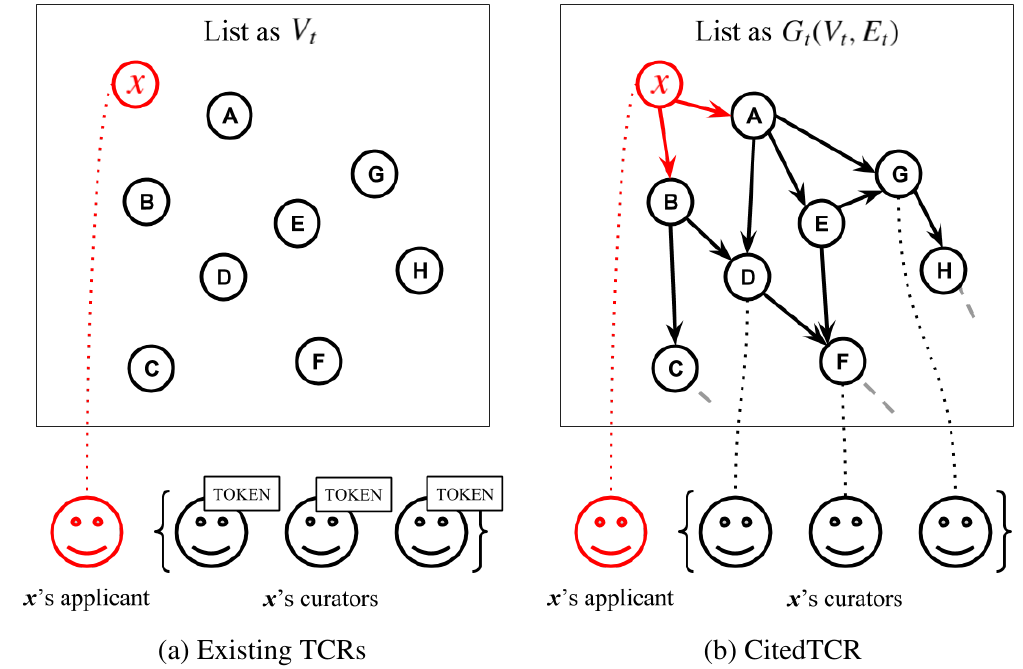
Fig. 1. TCRs in both cases select curators to decide whether to accept a newly proposed content x into the list of off-chain content { A , B , ···} . However, while existing TCRs (a) manage an unstructured list V t that can be curated by any user who stakes certain number of tokens, CitedTCR (b) manages an evolving directed acyclic graph (DAG)-structured list G t ( V t , E t ) whose curators are assigned according to citation